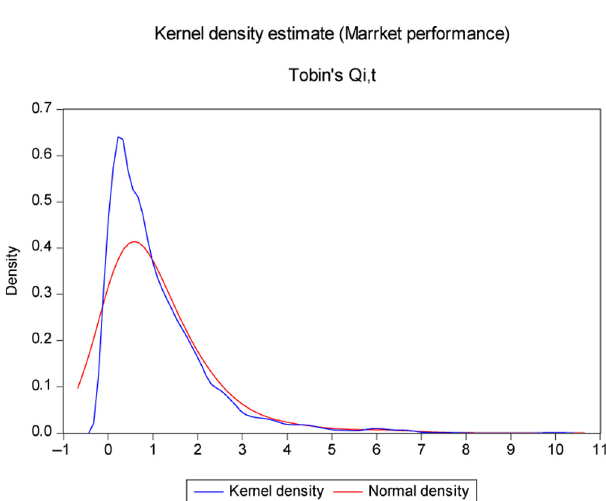
Figure 11. Non-normality of